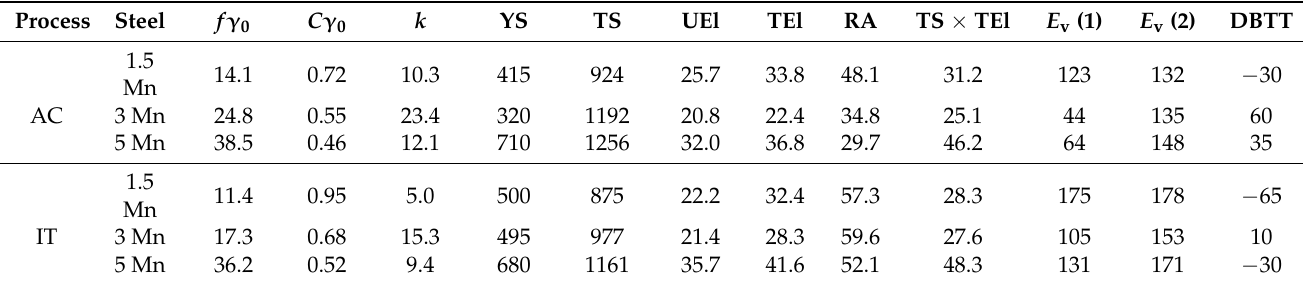
Table 2. Reverted austenite characteristics, tensile properties at 25 °C and impact toughness properties of the 1.5 Mn, 3 Mn, and 5 Mn steels subjected to the AC and IT processes.